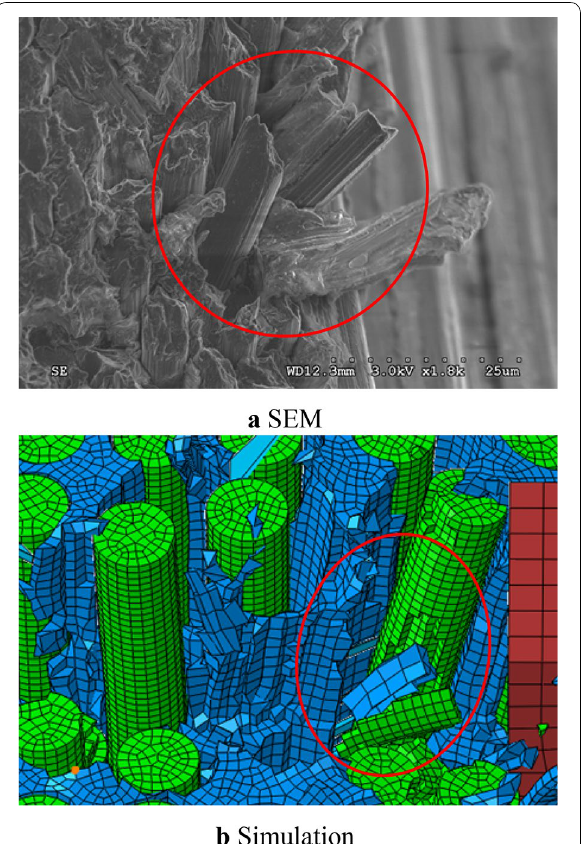
Figure 7 Surface cracks due to elastic bending deformation of carbon